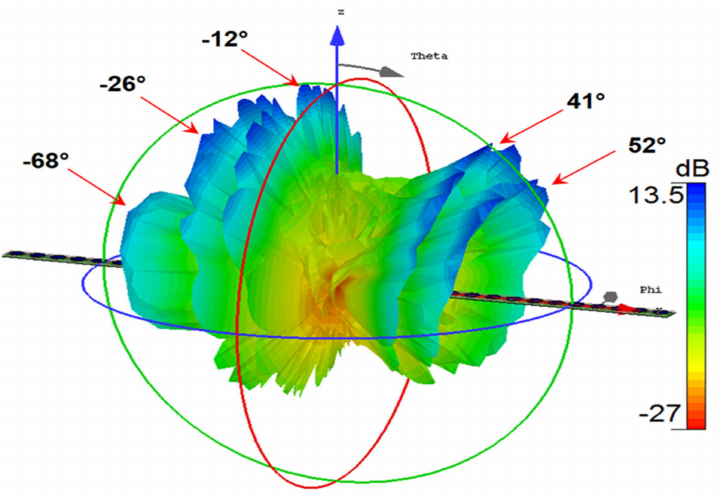
Figure 8. 3D multiple beams of the proposed beamforming scheme using 32 − linear